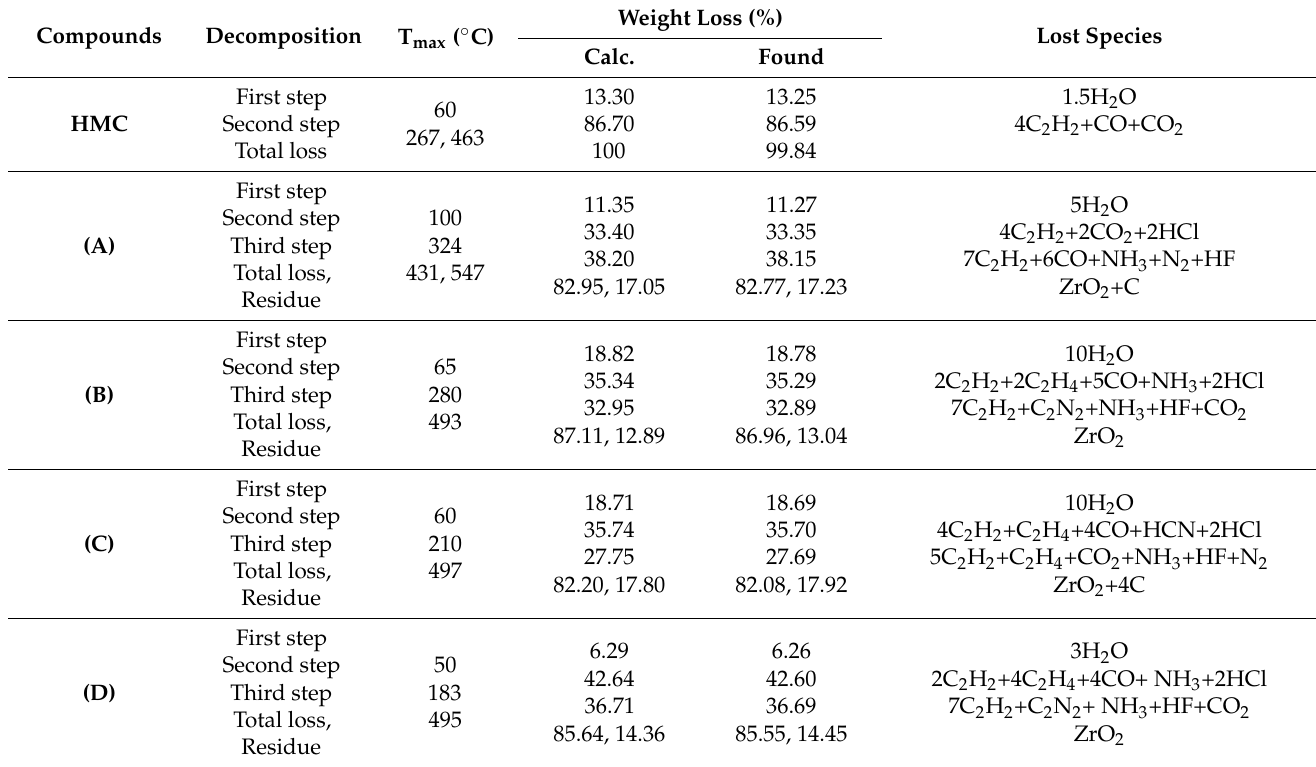
Table 5. The maximum temperature T max ( ◦ C) and weight loss values of the decomposition stages for HMC and their Zr(IV) complexes (A) , (B) , (C) , and (D)